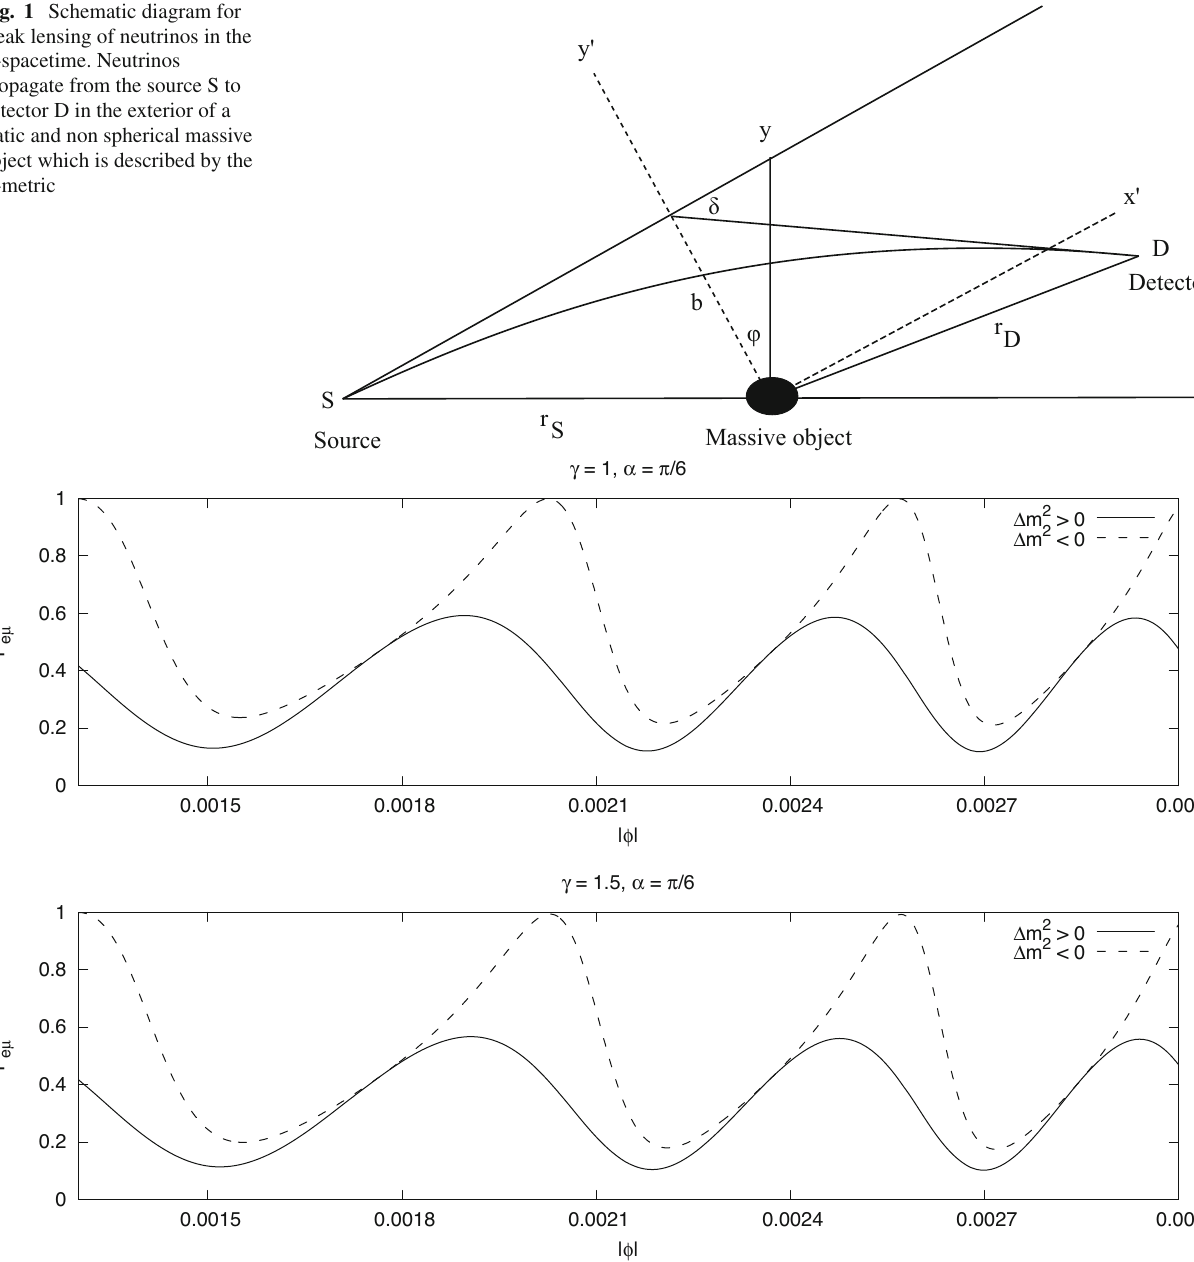
tively. Values of the other parameters are as follows: M ADM = 1 M (cid:15) , (cid:8) m 2 = 10 − 3 eV 2 , and the lightest neutrino here is considered to